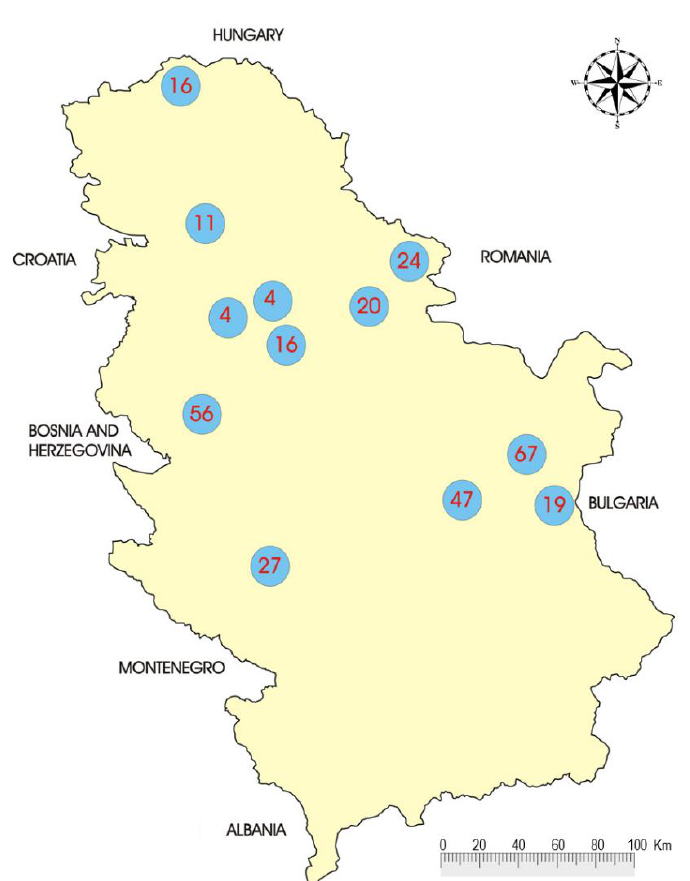
Figure 3. Locations and numbers of sampled bats in Serbia (2007–2008). Sampling locations are presented by circle positions on the map, and numbers of bats sampled at each location are shown in corresponding circles (from [25]).